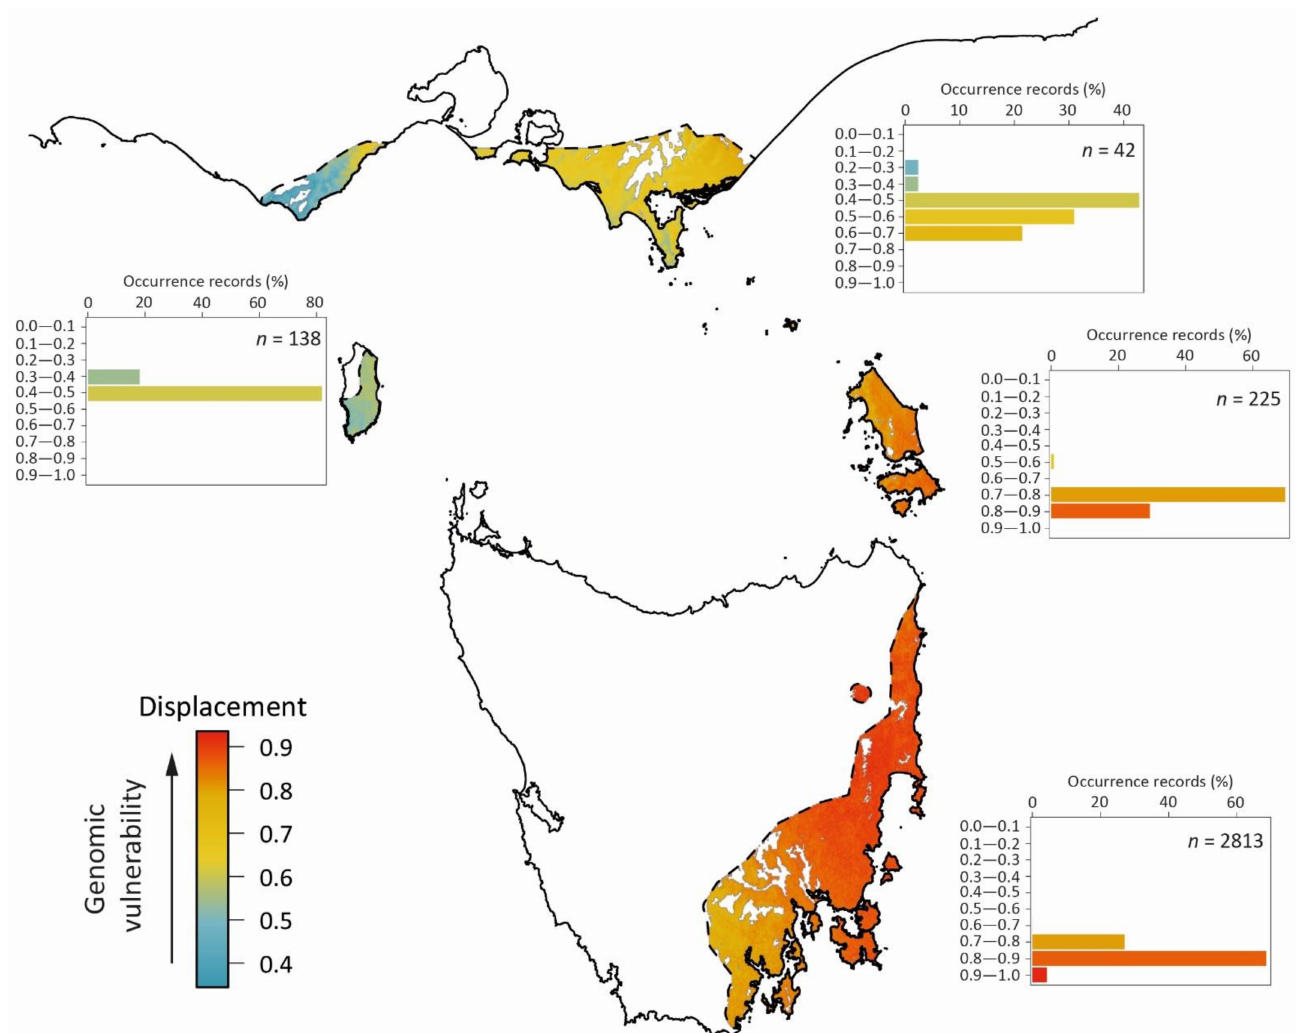
Figure 7. The predicted genomic vulnerability of E. globulus populations to maladaptation under climate change. The main map shows the genomic vulnerability (colour scaled from blue to red) over the native geographic range of E. globulus , quantified as the displacement (Euclidean distance) predicted for grid cells in the three-dimensional RDA space shown in Figure 5 from the contemporary to the 2070s climate. White areas within the geographic range are outside the contemporary range for the species in the RDA space. The predicted least vulnerable populations are those on King Island and in the western Otways (shown in blue), and the most vulnerable are populations on the central and northern east coast of Tasmania (shown in red). Inset bar-charts show the percent of occurrence records within each decile bin of the predicted genomic vulnerability index for four regions (clockwise): mainland Australia (Victoria), Furneaux Islands, Tasmania, and King Island (e.g., of the recorded occurrences of E. globulus on King Island, 80% are located in grid cells that are displaced by 0.4–0.5 from the contemporary to predicted 2070s climate, indicating moderate genomic vulnerability). The number of records assessed for each region (n) is also shown in these bar-charts. The area indicated to be outside of the range of E. globulus on King Island has been extensively cleared for agriculture, but the occurrence of an isolated remnant tree within this area suggests that it may have been previously within the past range of E. globulus